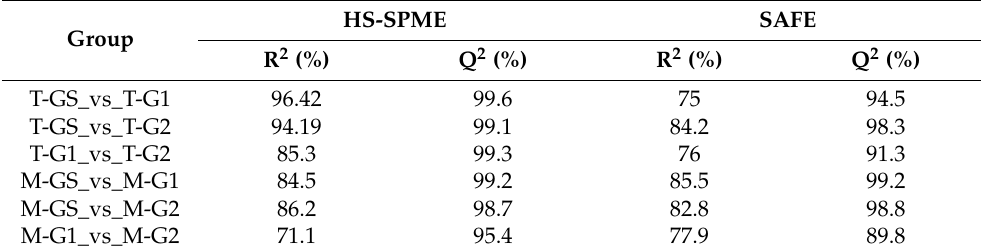
Table 2. The fitting parameters of OPLS-DA